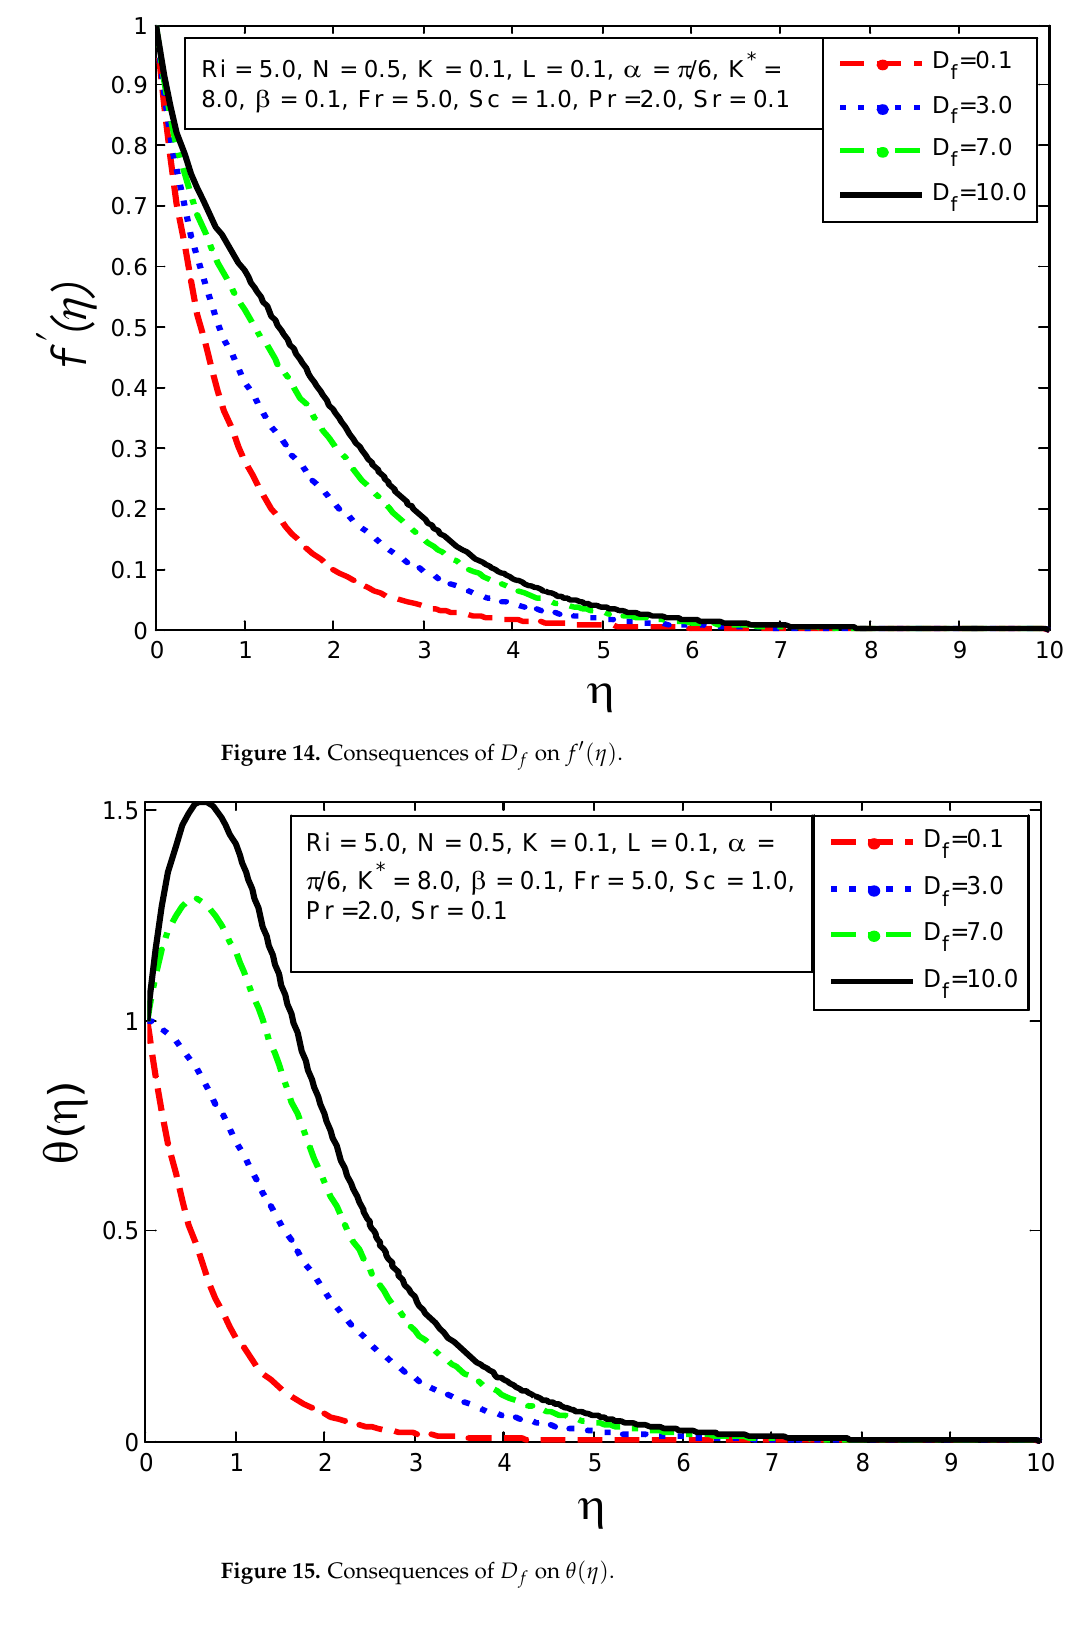
Figure 13. Consequences of Pr on